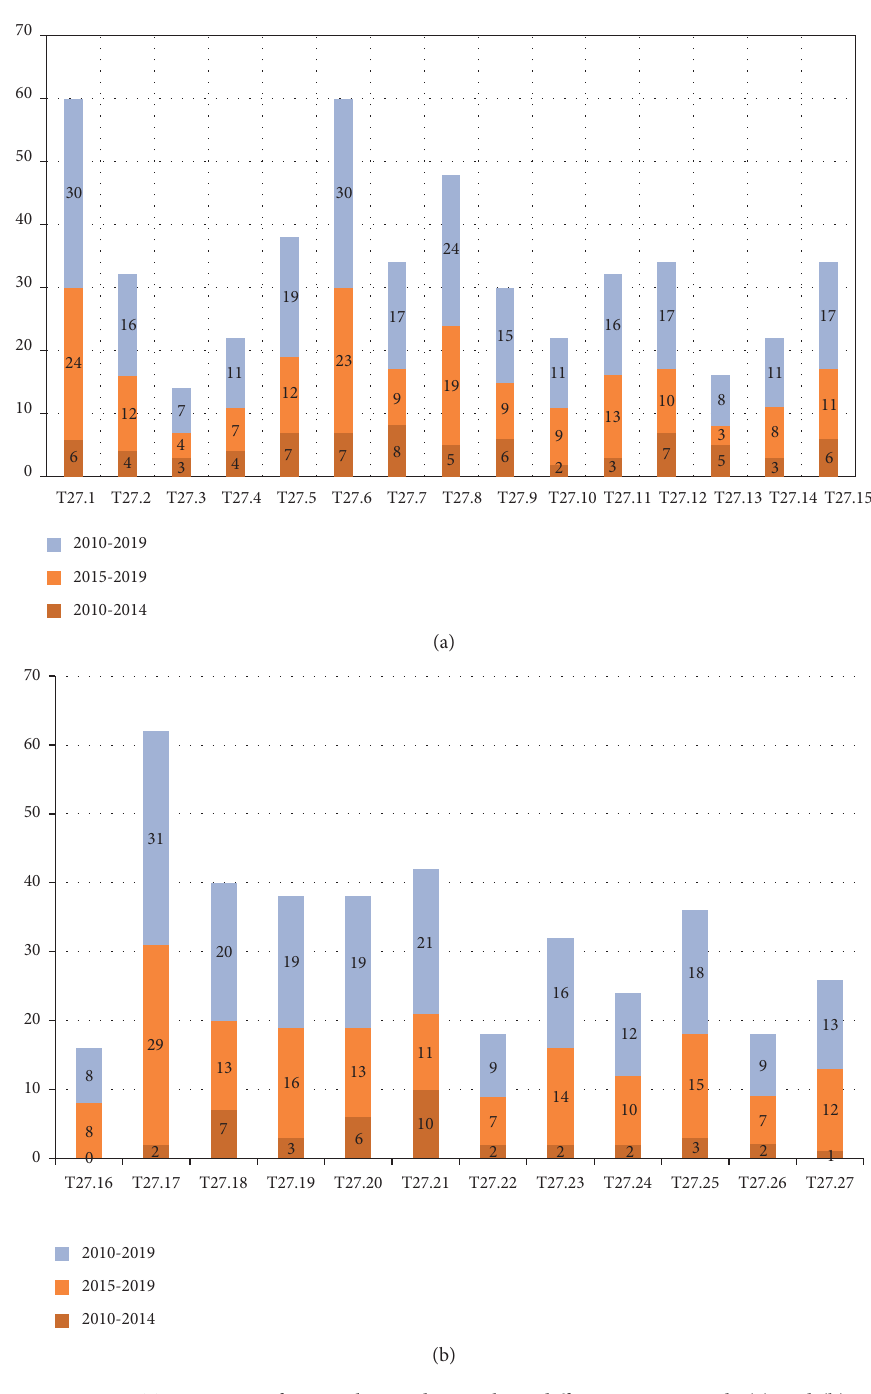
Figure 15: Twenty-seven factor solution during three different time periods (a) and